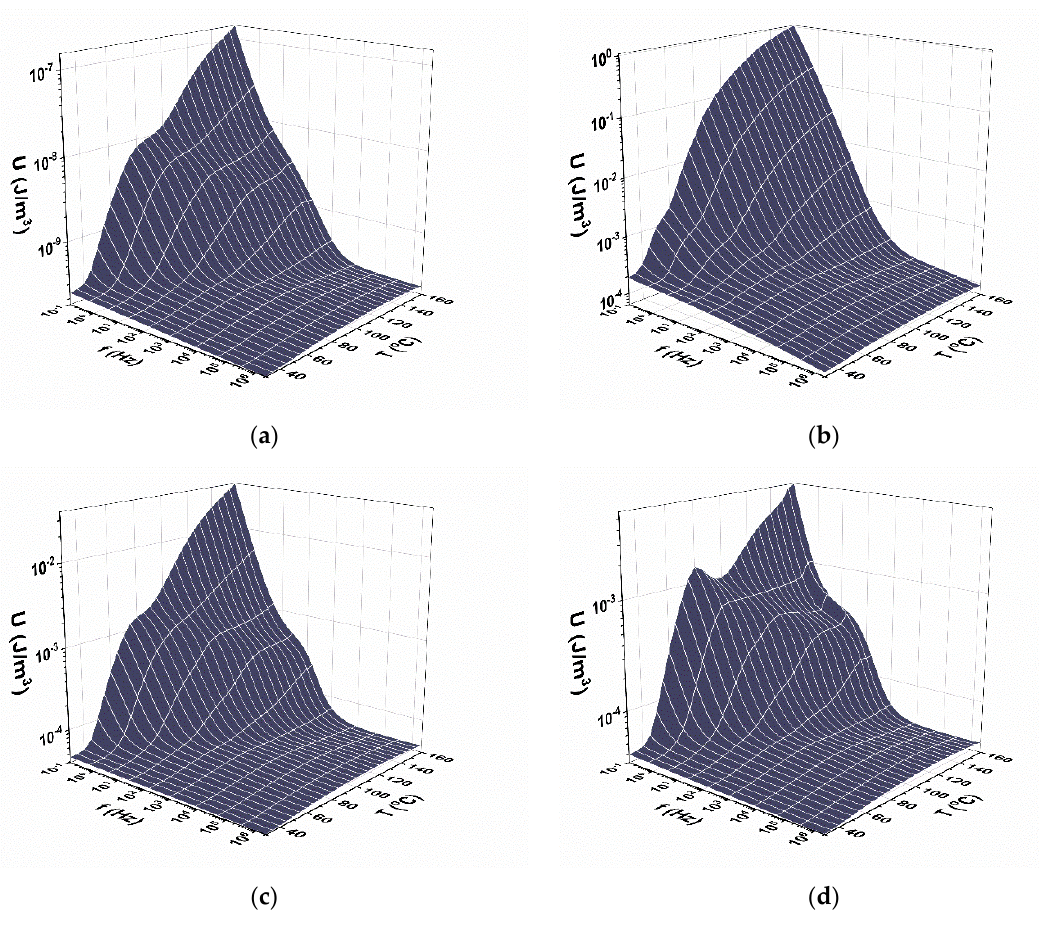
Figure 5. The variation of energy density as a function of frequency and temperature for the nanocomposites with 3 phr: ( a ) CB; ( b ) MWCNT; ( c ) GnP; ( d ) ND